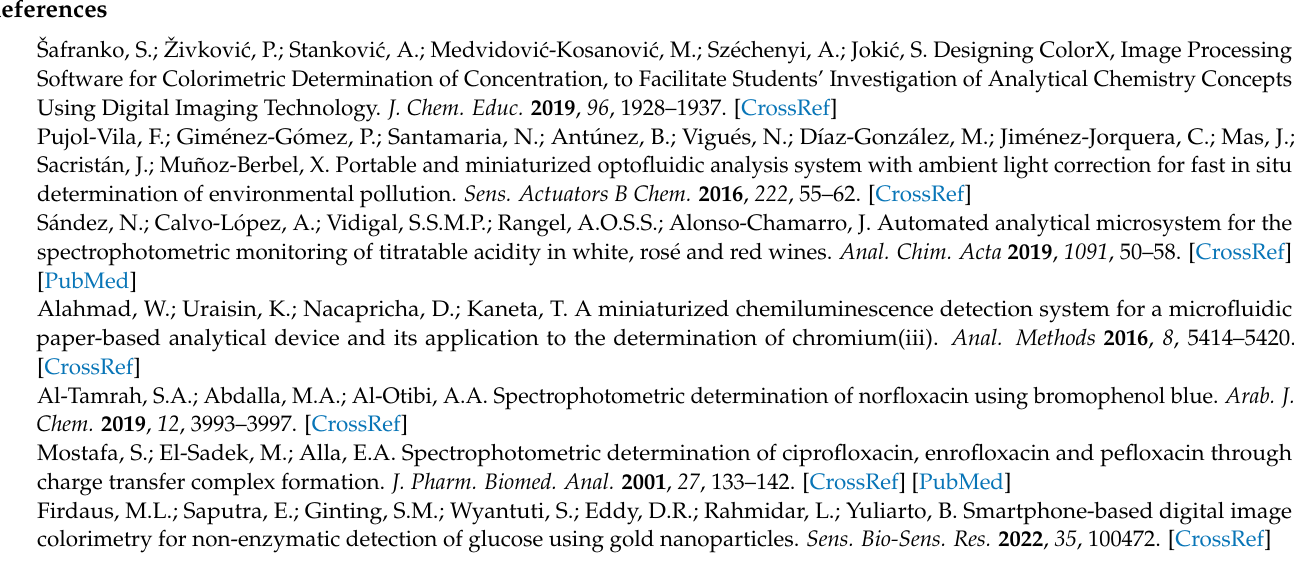
sulfate. Figure S5: Design of 3D Holder using Rhinoceros program; Figure S6: Electronic circuity used for experimentation. Figure S7: Photograph of the used webcam. Figure S8: Programming